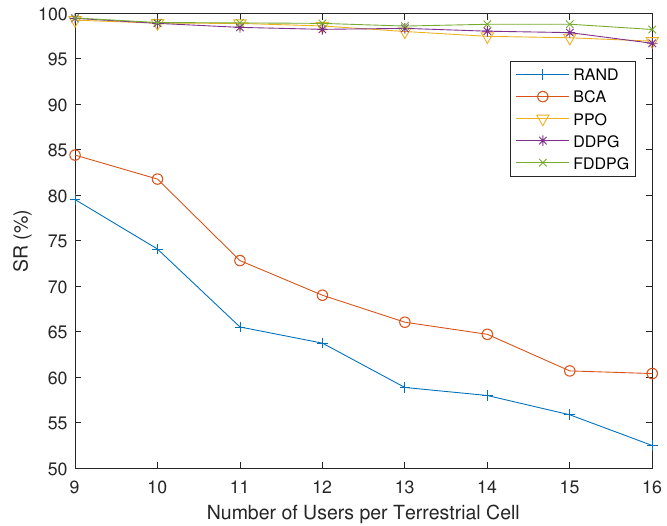
Figure 6. The satisfied ratio with different